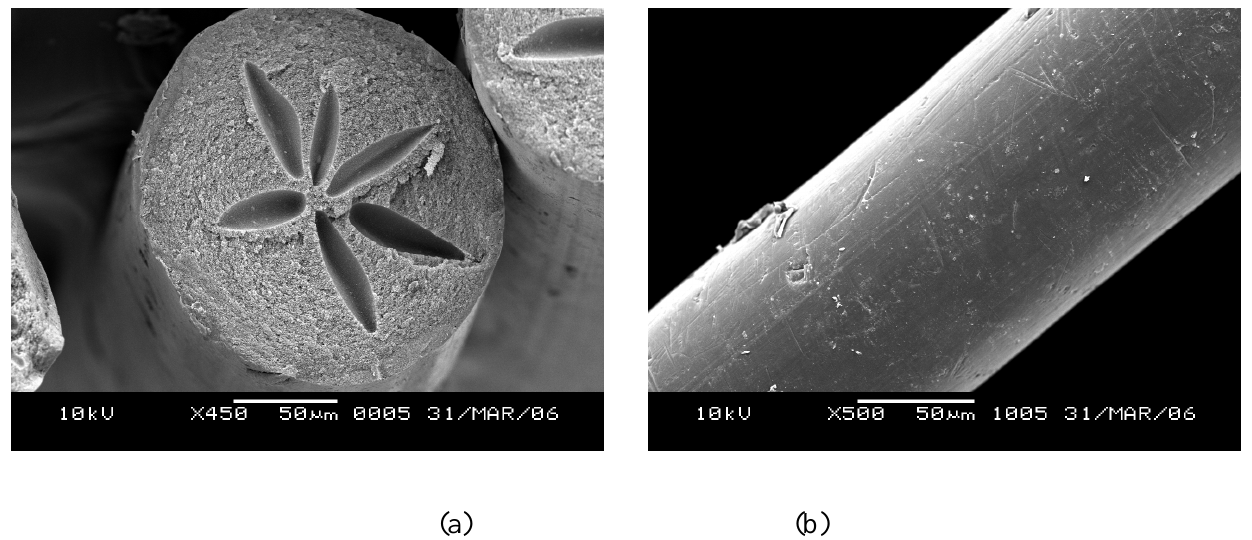
Figure 2. SEM photos of PMIA fibers from ionic liquid [Bmim]Cl; a) cross-section, b) outer surface.